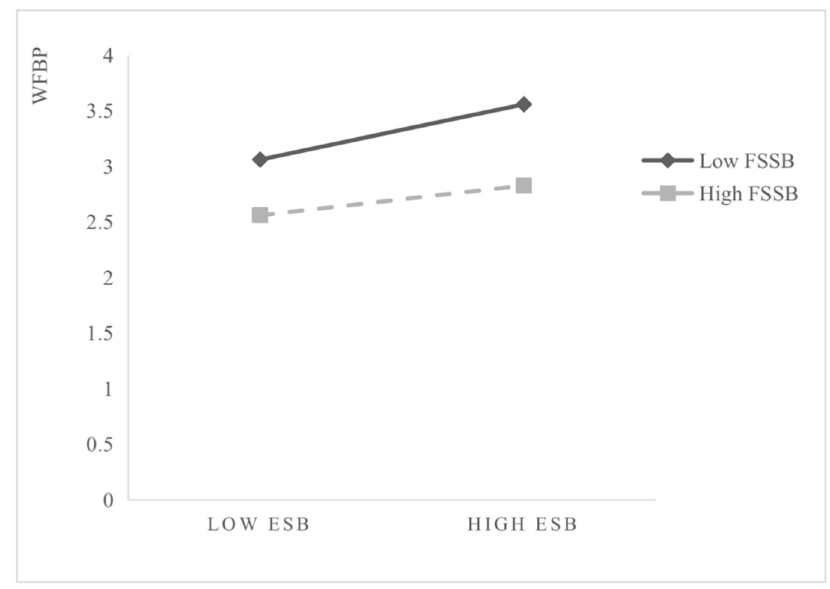
Figure 2. Interaction effect of FSSB.